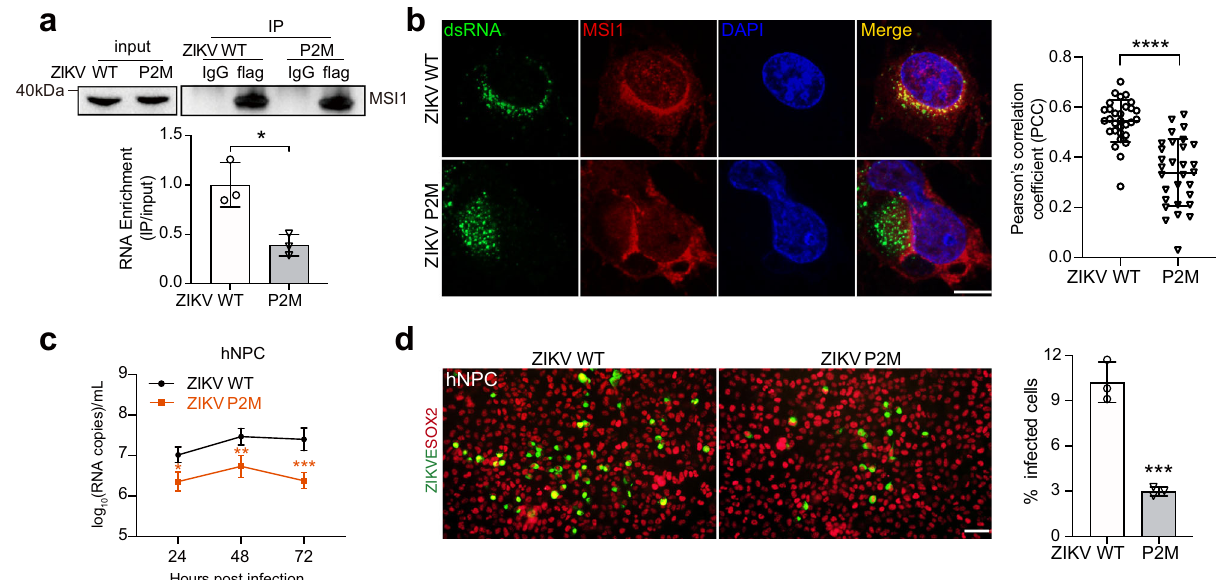
Fig. 4 | The xrRNA2 AGAA tetraloop participates in MSI1 binding in vivo and regulates ZIKV replication. a RNA-IP analysis from WT or P2M infected BHK-21 cellstransfected with fl ag-MSI1.Westernblotshowsimmunoprecipitations(IPs)by immunoglobulin G (IgG) and fl ag antibodies. Input (5%) represents whole-cell extract.Westernblotwasprobedwithantibodiesagainst fl ag.TheboundviralRNA from the IP was analyzed by qRT-PCR. Graph below shows qRT-PCR performed on bound RNA from IP. RNA-IP values are presented as the ratio to the input after subtraction of the IgG background. Data are mean±SD. n =3 independent experiments. Two-sided Student ’ s t test, * P <0.05. ( P =0.0237). b Confocal micro- scopy of BHK-21 cells transduced with MSI1-expressing lentiviruses (MOI=10) and infected with the ZIKV WT or P2M viruses (MOI=1) for 24h. Fixed cells were